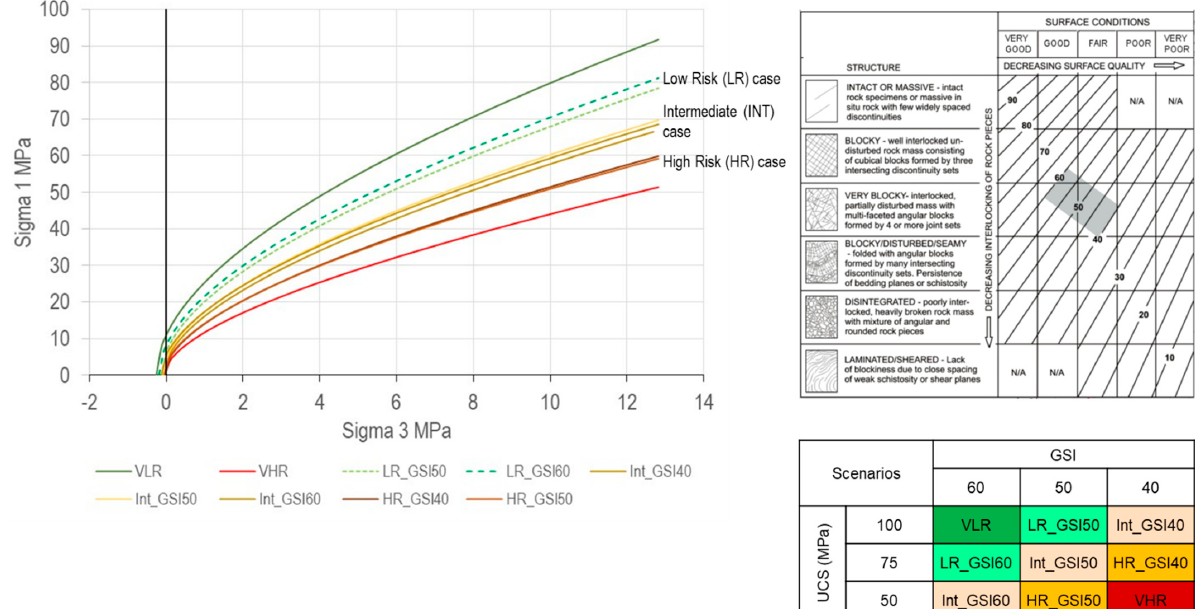
Figure 8. Example of a risk ‐ based numerical approach to consider the impact of inhomogeneous rock mass conditions.